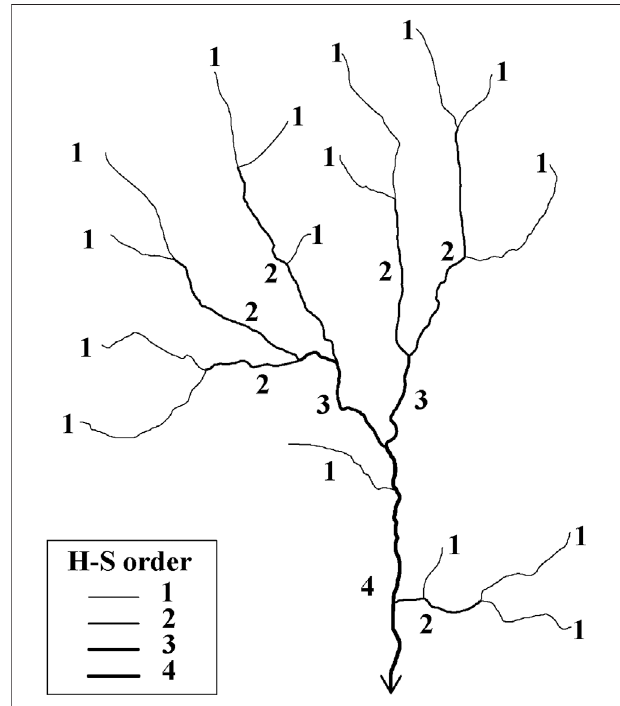
FIGURE 1 | H-S ordering method schematic diagram for the illustrated river network with H-S order 4. There are 16 streams with H-S order 1, 6 streams with H-S order 2, 2 streams with H-S order 3, and 1 stream with H-S order 4. The arrow at the bottom is the outlet of this river